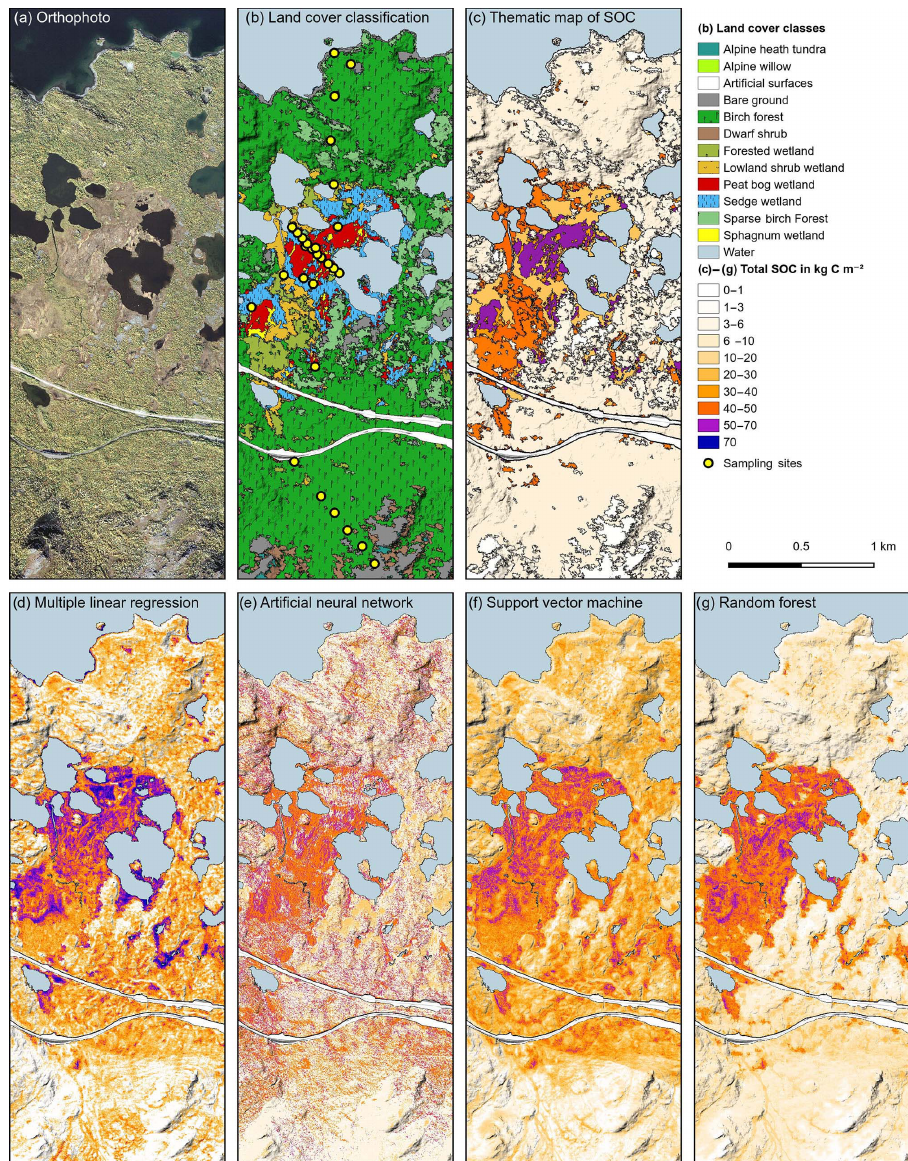
Figure 4. A close up of the area near Stordalen mire comparing different maps. (a) Illumination-corrected orthophoto (©Lantmäteriet, I2014/00691). (b) Land cover classification, (c) soil organic carbon (SOC) storage using a thematic mapping approach. (d–g) Maps developed using different machine-learning models. Each map uses all input soil pedons and pseudo-sampling points; (d) multiple linear regression model (MLR), (e) artificial neural network (ANN), (f) support vector machine (SVM) and (g) random forest (RF).